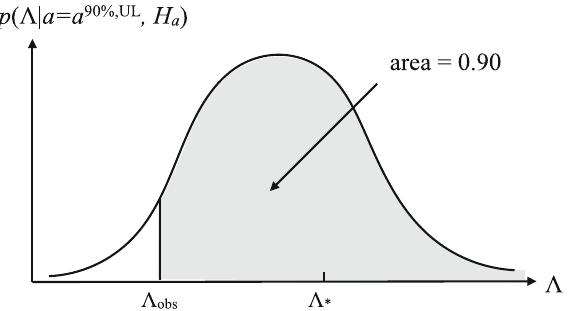
Fig. 5 Graphical representation of a frequentist 90% confidence level upper limit. When a = a 90% , UL , the probability of obtaining a value of the detection statistic Λ ≥ Λ obs is equal to 0 .